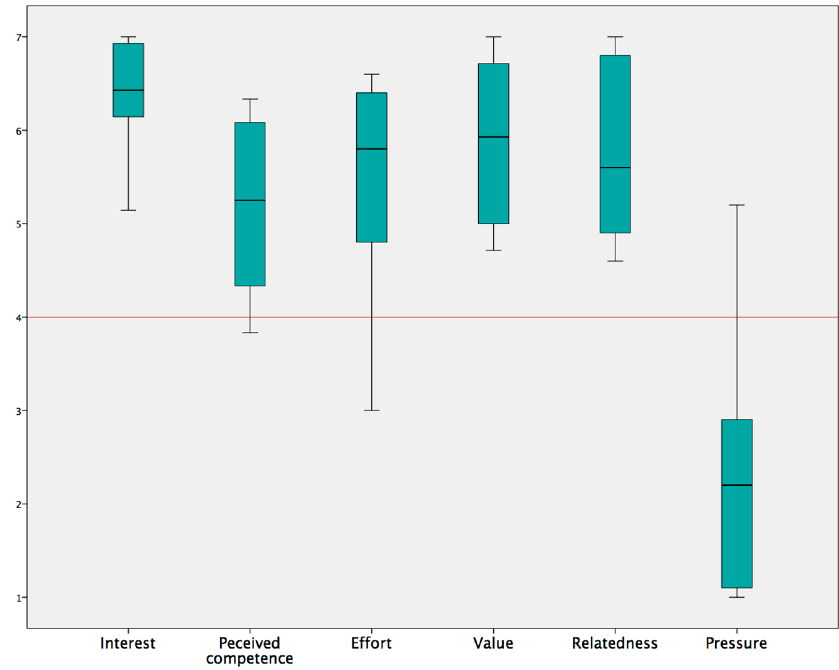
Figure 12. Subscale findings of the Intrinsic Motivation Inventory questionnaire evaluated in patients with shoulder